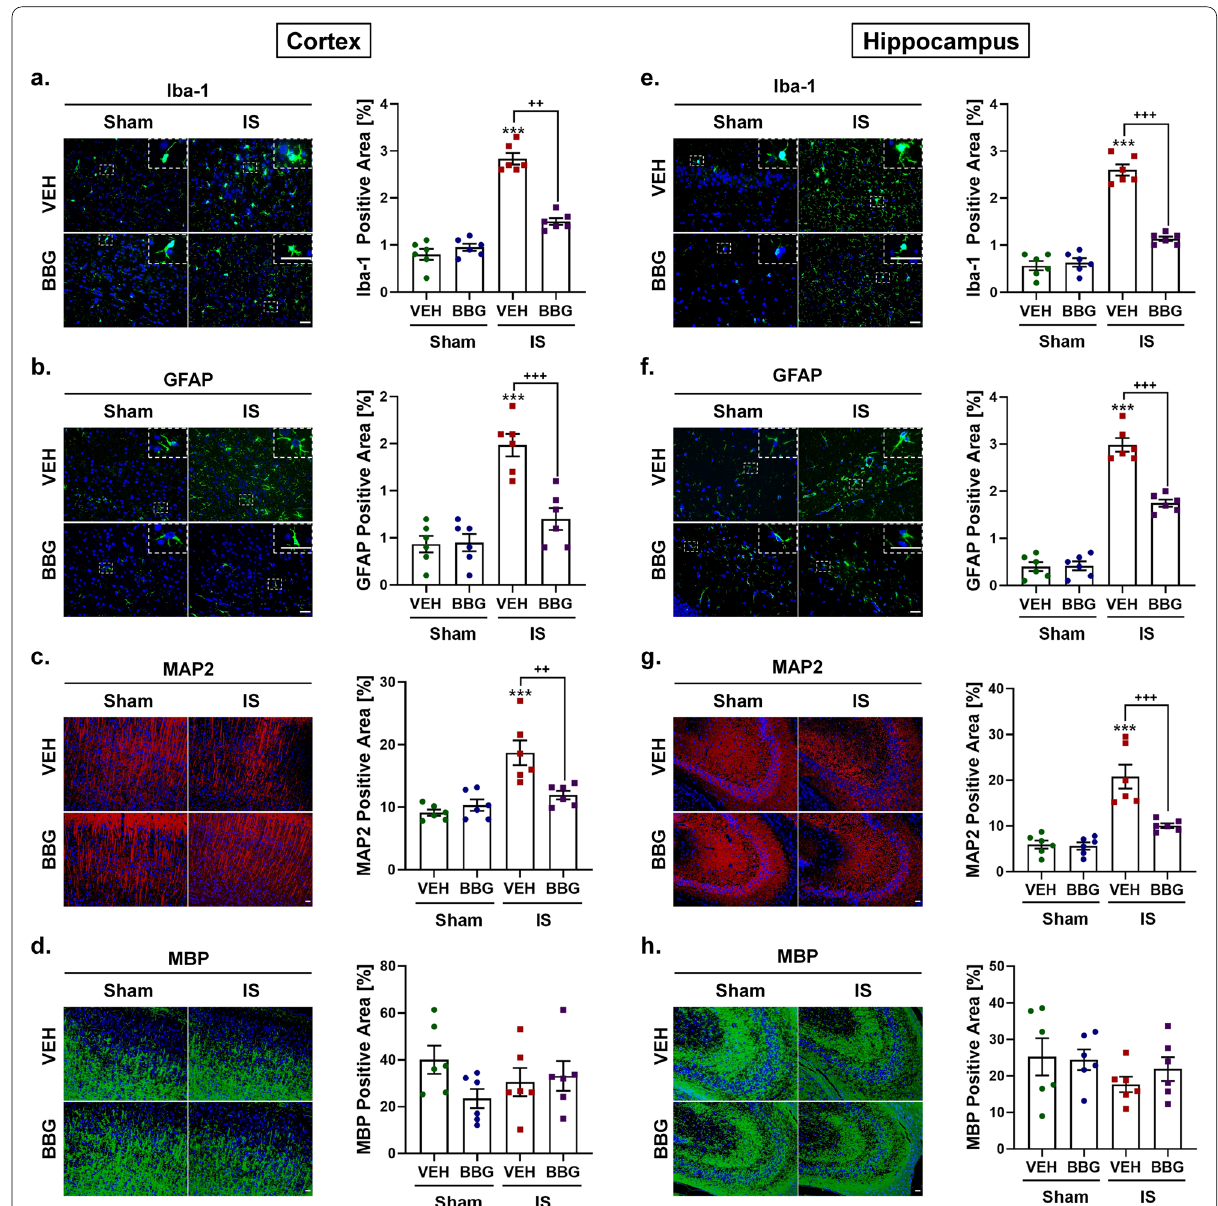
Fig. 7 Inhibition of P2X7R attenuated IS-induced gliosis and neuronal loss in the cerebral cortex and hippocampus. ( a, b, e, f ) Representative immunofluorescence and quantification of Iba-1 and GFAP illustrating resistance to microgliosis and astrogliosis due to decreased expression of Iba-1and GFAP in the cerebral cortex and hippocampus of IS-BBG mice compared to IS-VEH mice. Magnification 40. Insets show a higher × magnification view. Scale bar, 20 μm. ( c, g ) Representative immunofluorescence and quantification of MAP2 illustrating resistance to neuronal loss due to decreased expression of MAP2 in the cerebral cortex and hippocampus of IS-BBG mice compared to IS-VEH mice. Magnification 20. Scale × bar, 20 μm. ( d, h ) Representative immunofluorescence and quantification of MBP illustrating no significant difference in white-matter integrity in the cerebral cortex and hippocampus among the four groups. Magnification 20. Scale bar, 20 μm. All images were taken under identical × exposures and conditions. n 6 mice per group. * p < 0.05, ** p < 0.01 and *** p < 0.001 as compared to sham-VEH mice; + p < 0.05, ++ p < 0.01 and = +++ p < 0.001 as compared to IS-VEH mice. One-way ANOVA with Tukey’s multiple comparisons or Kruskal–Wallis with Dunn’s multiple comparisons test were performed for statistical analysis. Data are represented as mean SEM. Abbreviations: IS, inflammatory soup; BBG, brilliant blue G; VEH, ± vehicle; Iba-1, ionized calcium-binding adaptor molecule-1; GFAP, glial fibrillary acidic protein; MAP2, microtubule-associated protein 2; MBP, myelin basic